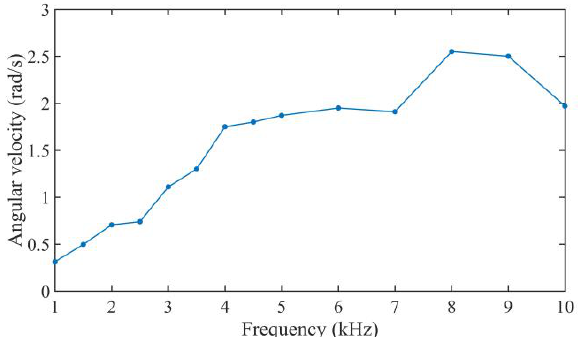
Figure 12. Average angular velocity of the motor.